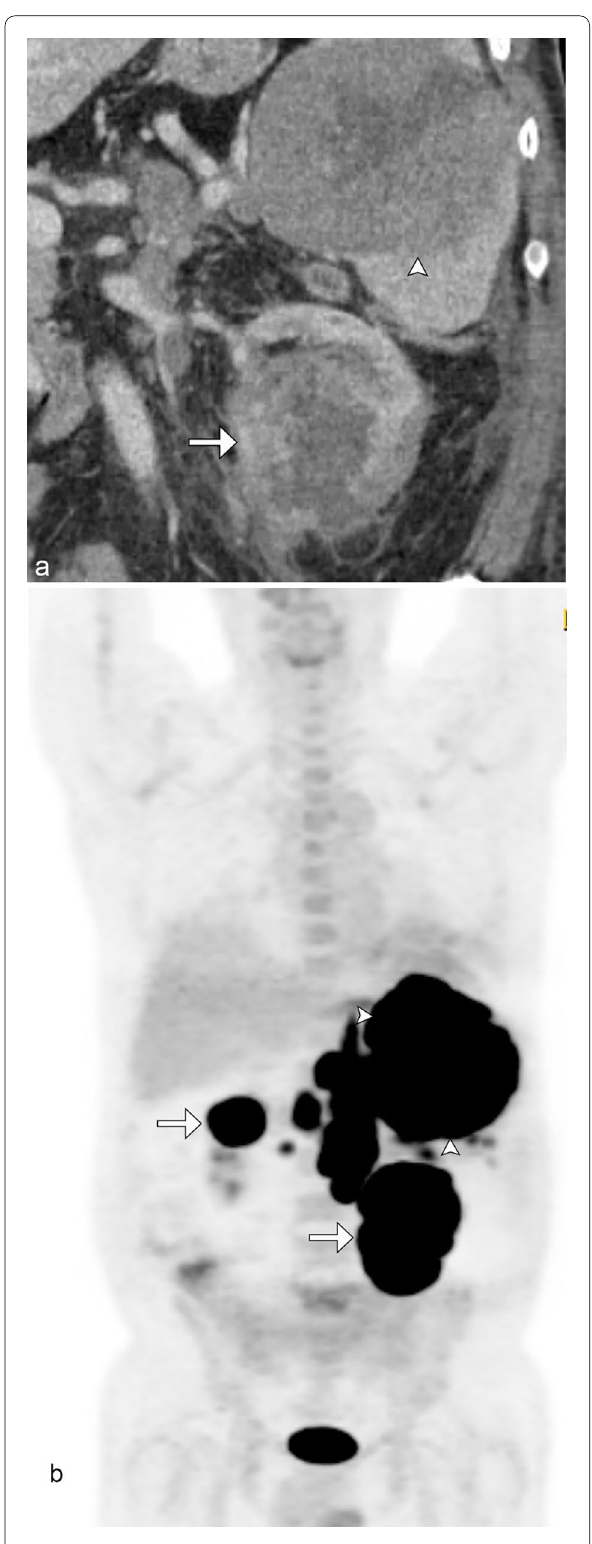
Fig. 4 Solitary mass of renal lymphoma. Coronal CT post contrast image ( a ) demonstrates a solitary hypoenhancing left lower pole renal mass (arrow). Note the mass-like infiltration of the spleen (arrowhead) and retroperitoneal lymphadenopathy. PET/CT ( b ) shows the marked F18-FDG avid bilateral renal masses (arrows), retroperitoneal lymphadenopathy, and splenic mass (arrowheads), consistent with the diagnosis of large b-cell